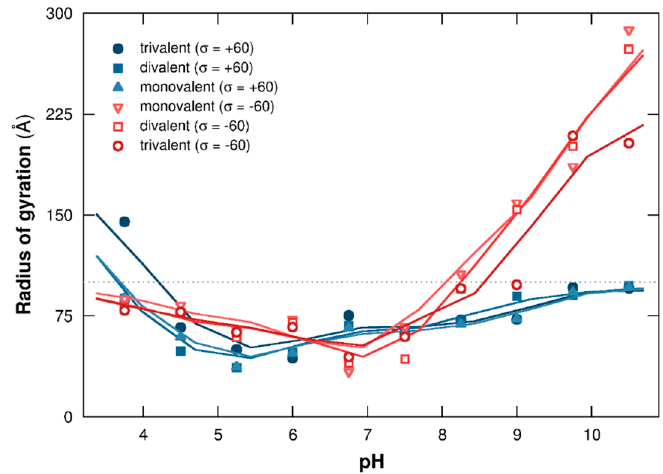
Figure 7. PP mean square radius of gyration as a function of pH. NPs with surface charge densities σ of − 60 (red open symbols) and +60 (blue closed symbols) mC/m 2 , monovalent counterions and salt particles (valencies +1, +2, or +3) are considered. Ionic strength is fixed to 1 × 10 -4 M, and the dotted line represents the NP radius (100 Å).